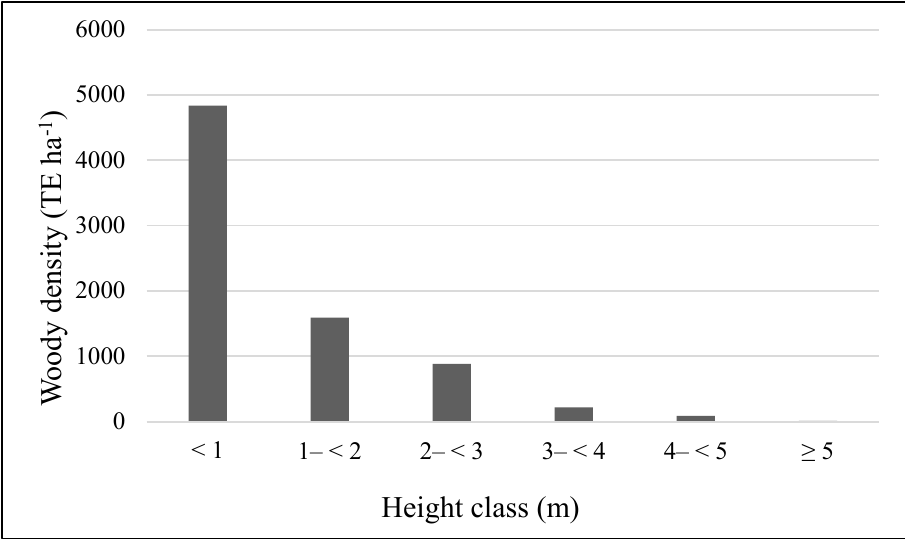
Table 2. Mean density (TE ha − 1 ) ± SE of woody plants in different height classes around the six villages. Height Class (m)